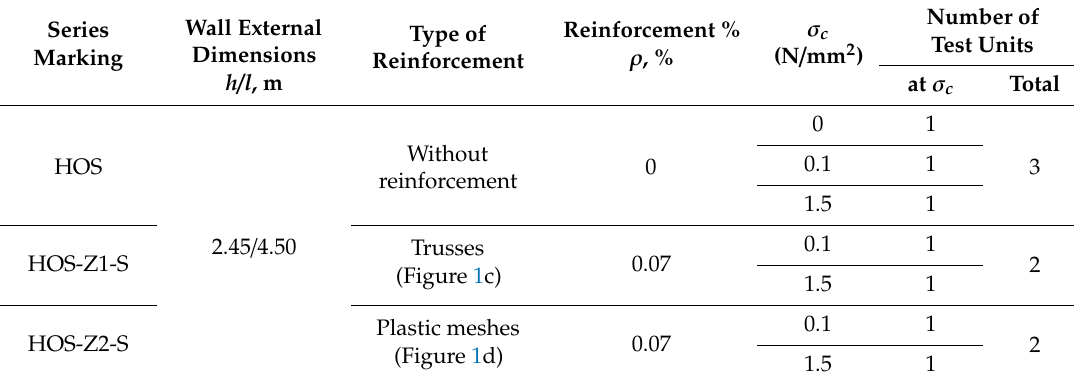
Figure 3. Geometry of models made of silicate masonry units, dimensions are in centimeters. Table 2. Research programme for walls made of calcium silicate masonry units.